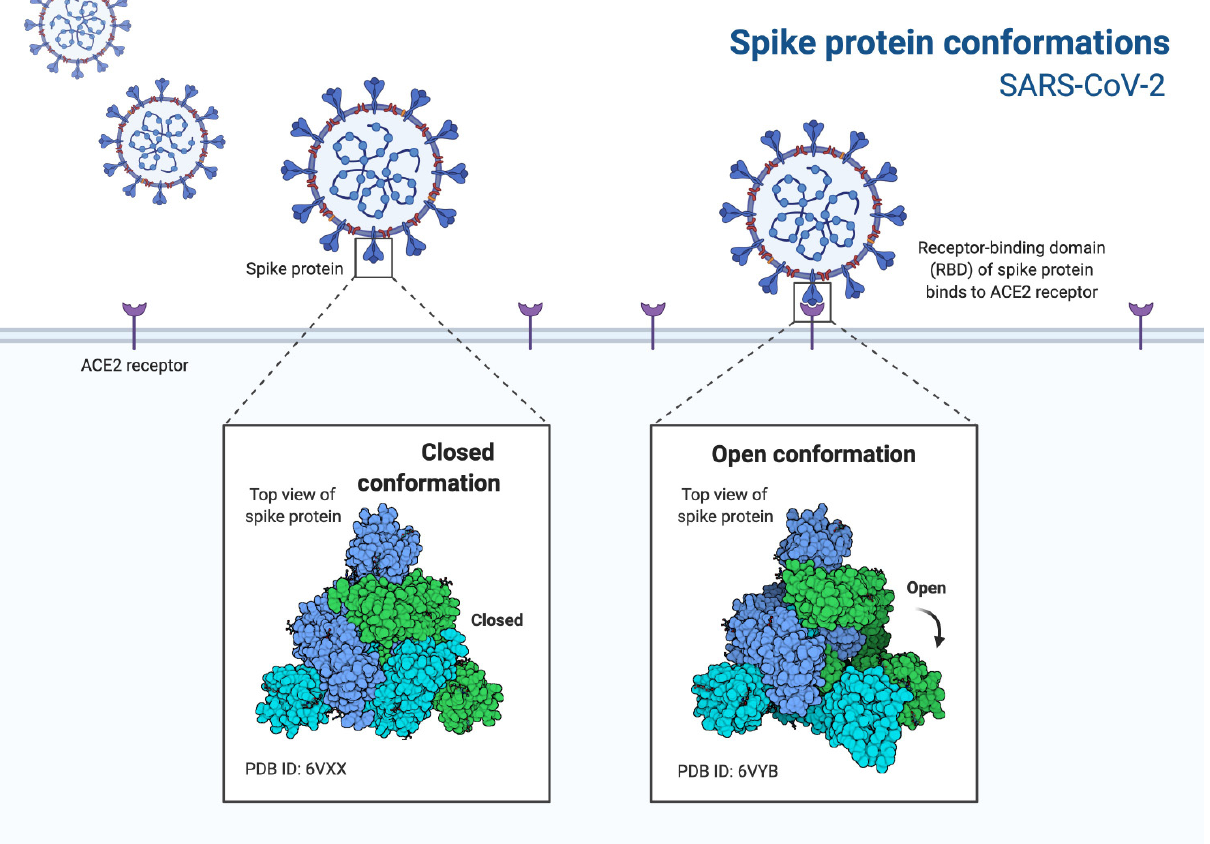
Figure 5. Spike-protein trimer in closed ( left ) and open ( right ) states of the SARS-CoV-2 S glycoprotein. Created with BioRender.com.